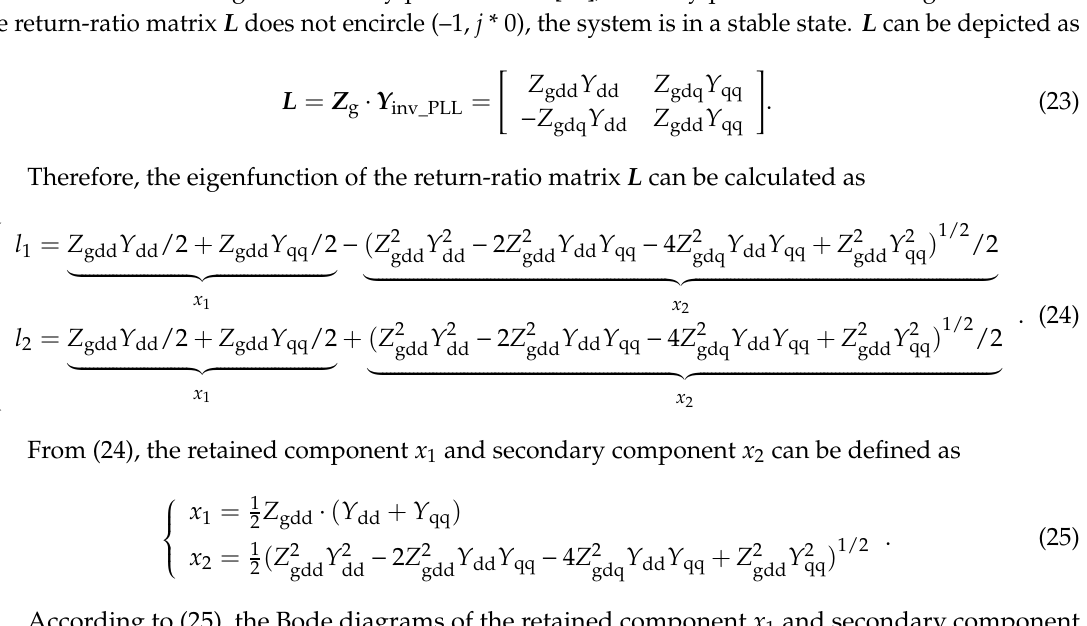
Figure 5. The Bode diagrams of the retained component x 1 and secondary component x 2 .